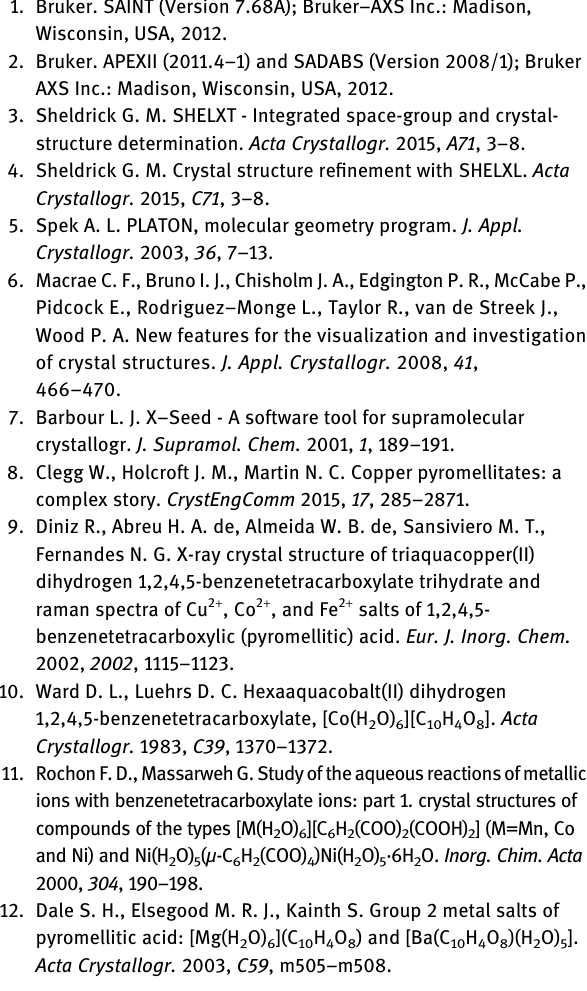
atoms on the twofold axis while the other four O atoms are related to in pairs by this same axis. The Cu – O distances are in the range 2.044(14) – 2.124(9) Å and the O – Cu – O angles are between 86.17(2) ° and 179(3) ° . The (H B4C) 2 – anion is 2 located around a center of symmetry. The benzene ring internal angles are 117.90(11) ° and 118.28(11) ° for the substituted C atoms and 123.82(11) ° for the unsubstituted. The exterior angles are 127.42(10) ° and 114.83(10) ° .